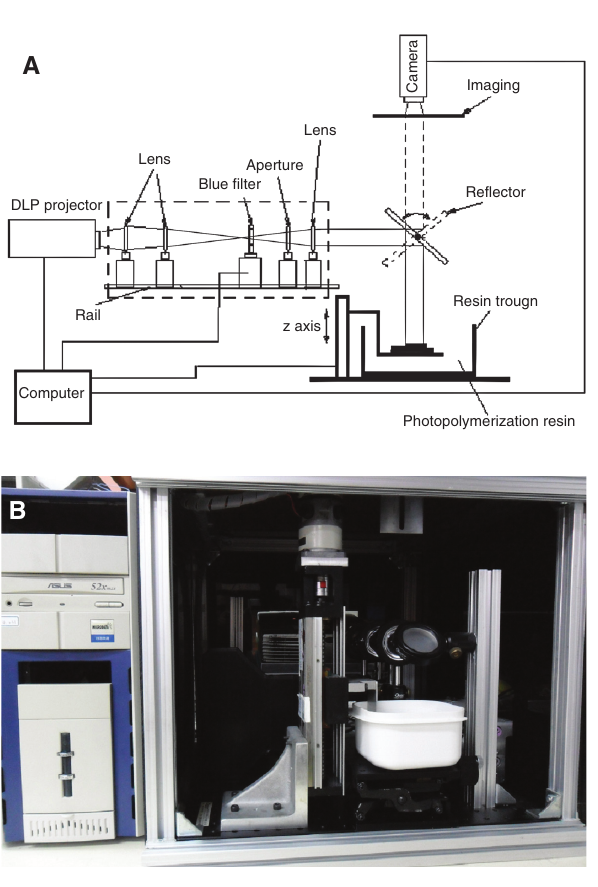
Figure 1 (A) Schematic and (B) setup of digital light processor RP